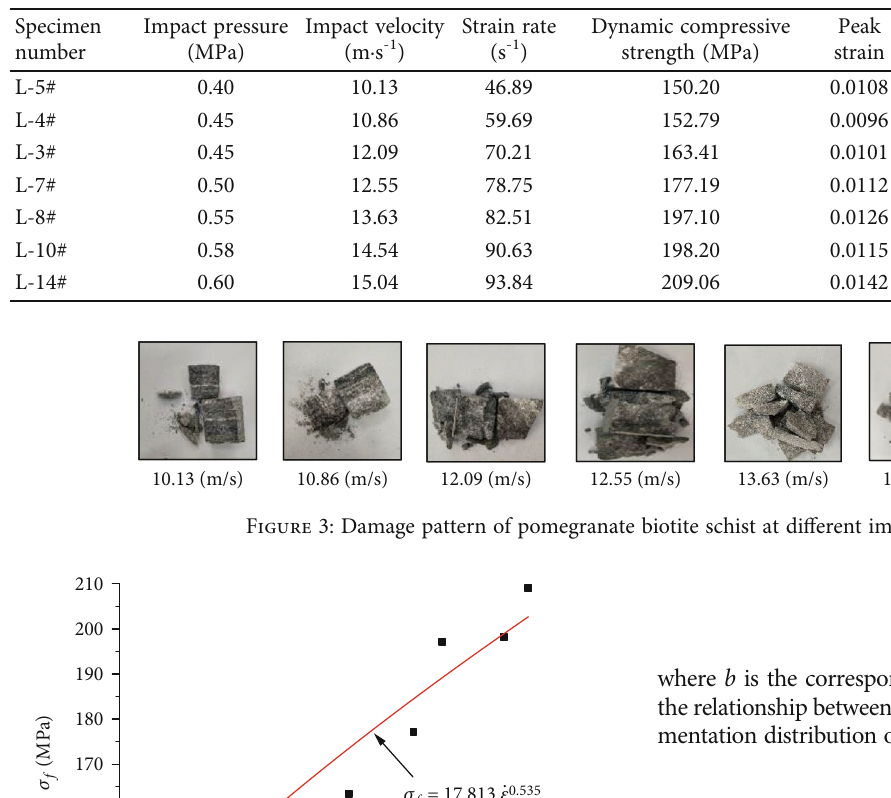
Table 2: Characteristic parameters of rock fragmentation at di ff erent strain rates.